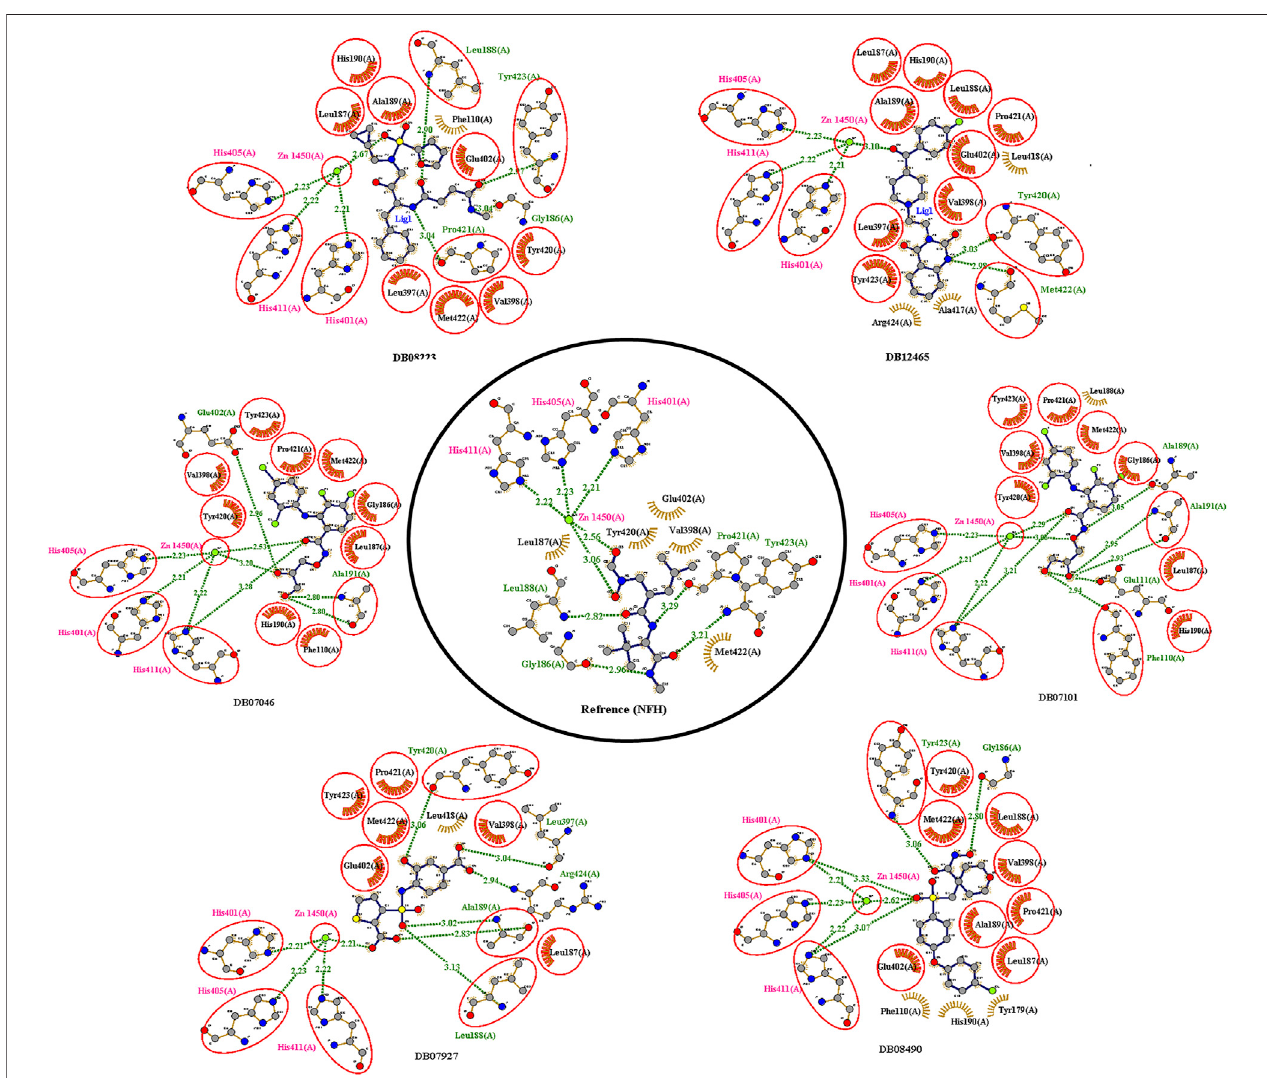
FIGURE 4 | 2D interactions of the top protein – ligand complex obtained by molecular